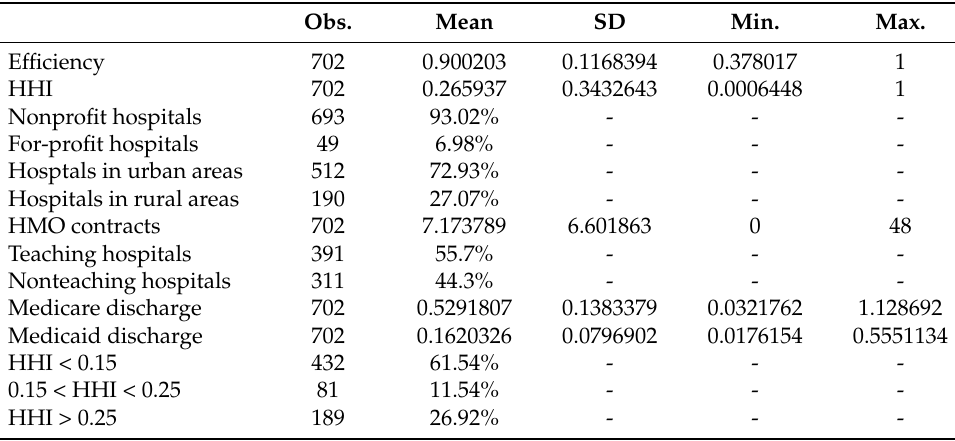
Table 2. Descriptive summaries of